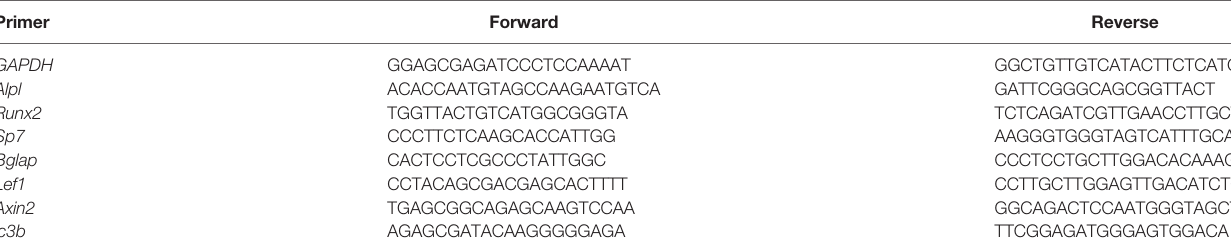
TABLE 1 | Sequences of primers used for qRT-PCR